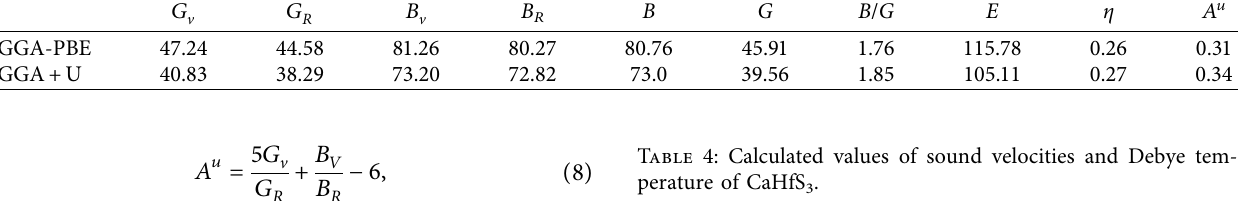
Table 3: Mechanical properties calculated from elastic constants of CaHfS